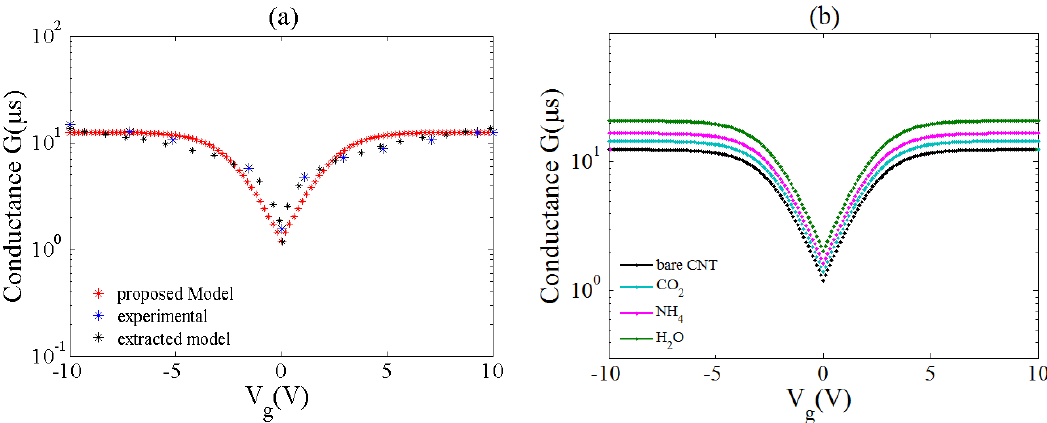
Figure 5. ( a ) Comparison of the proposed conductance model with experimental data and other modeling work. Acceptable consensus between our model and previous data can be seen; ( b ) Variation of the conductance in the presence of different gas molecules.